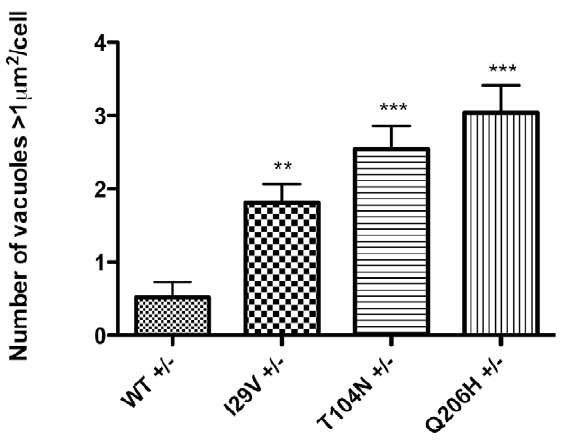
Figure 7. Mutant CHMP2B causes large cytoplasmic vacuoles. Cells expressing 3 different mutant CHMP2B had significantly more vacuoles with an area greater than 1 m m 2 in than cells expressing wild- type protein (One-way ANOVA p , 0.0001, + / 2 : cells grown in DMEM with FCS, without antibiotic).